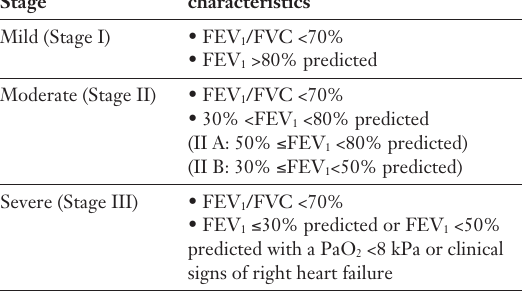
Classification of severity of COPD.